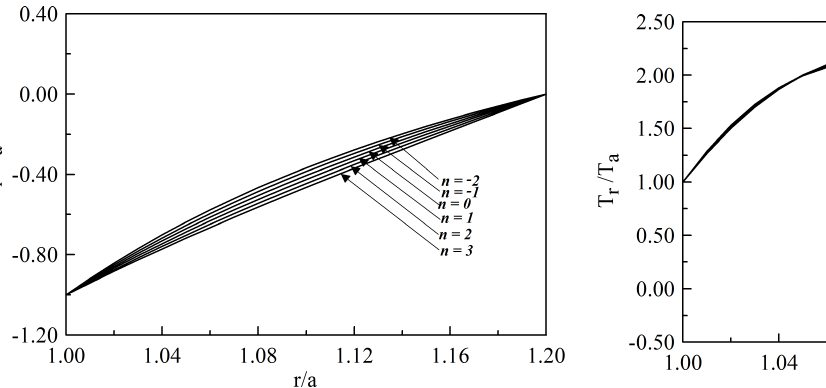
Figure 36: Radially distributed